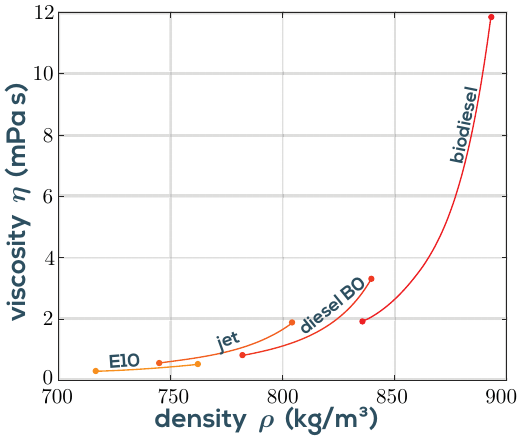
Figure 7. Viscosity-density diagram of fuels in a temperature range of 0–80 ◦ C (E10: 0–40 ◦ C) measured using the VDC100 + MFA200 setup shown in Figure 6. E10 is a fuel mixture of 10% anhydrous ethanol and 90% gasoline and B0 diesel is of fossil origin only. Viscosities are higher at lower temperature. In Figure 8, viscosities and densities of diesel mixtures are shown for three temperatures and the mixing models given in Equation (6) and Equation (7) are plotted as solid lines.